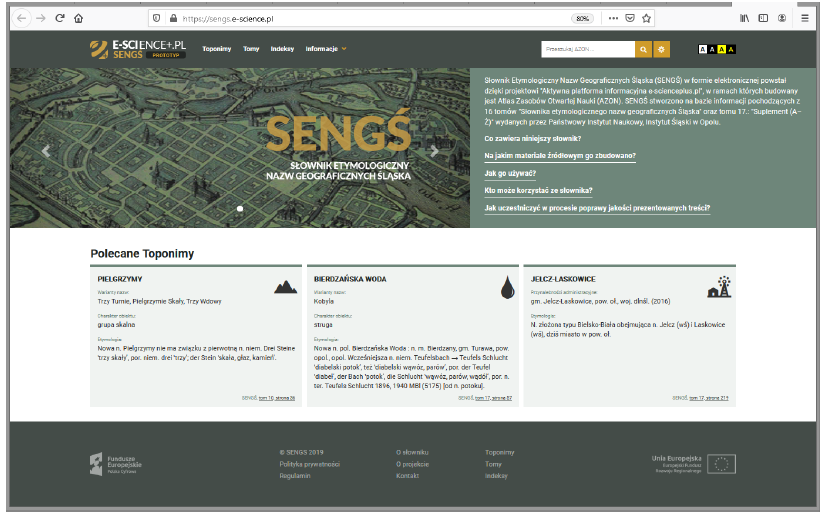
Figure 1. View of the SENG´S portal